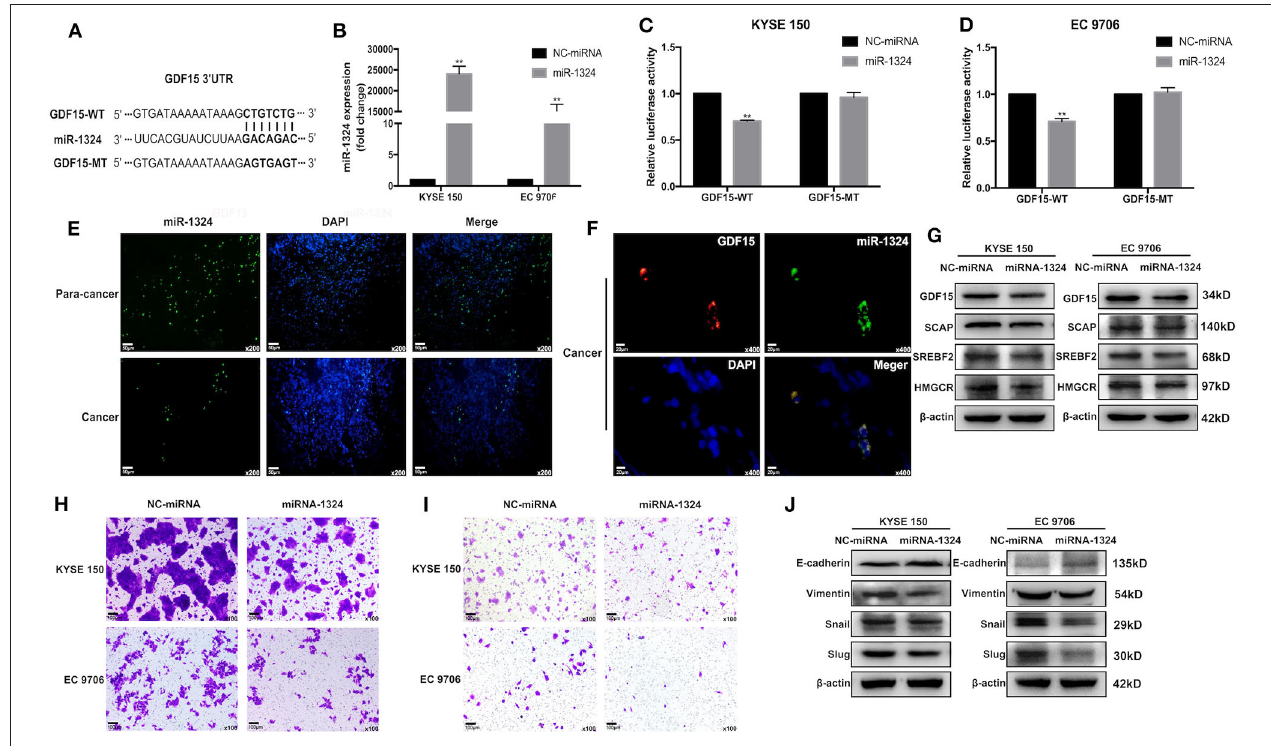
FIGURE 5 | GDF15 is a direct target of miR-1324. (A) A schematic of the target sites (wild and mutant) of miR-1324 in the 3 ′ UTR of the GDF15 mRNA transcript. (B) After the transfection of miR-1324 mimics, miR-1324 expression in ESCCs was determined by RT-PCR. (C,D) Dual-Luciferase reporter assays performed in ESCCs co-transfected with 3 ′ -UTR WT or MT plasmid with miR-1324 or negative control using Lipofectamine 2000. Relative luciferase activity was measured using the Dual-Luciferase ® Reporter Assay System. (E) Expression of miR-1324 (green) in EC and adjacent non-tumor tissues were determined by FISH, nuclei were stained with DAPI (blue). (F) Subcellular co-localization analysis of the interaction between GDF15 (red) and miR-1324 (green) in EC tissues, nuclei were stained with DAPI (blue). (G) Expression levels of SCAP, SREBF2, and HMGCR determined by western blotting. (H–J) Migration and invasion of ESCCs after transfection with miR-1324 mimics were determined using transwell chamber assays. Expression levels of EMT-associated proteins E-cadherin, vimentin, snail, and slug were determined by western blotting. ** P <